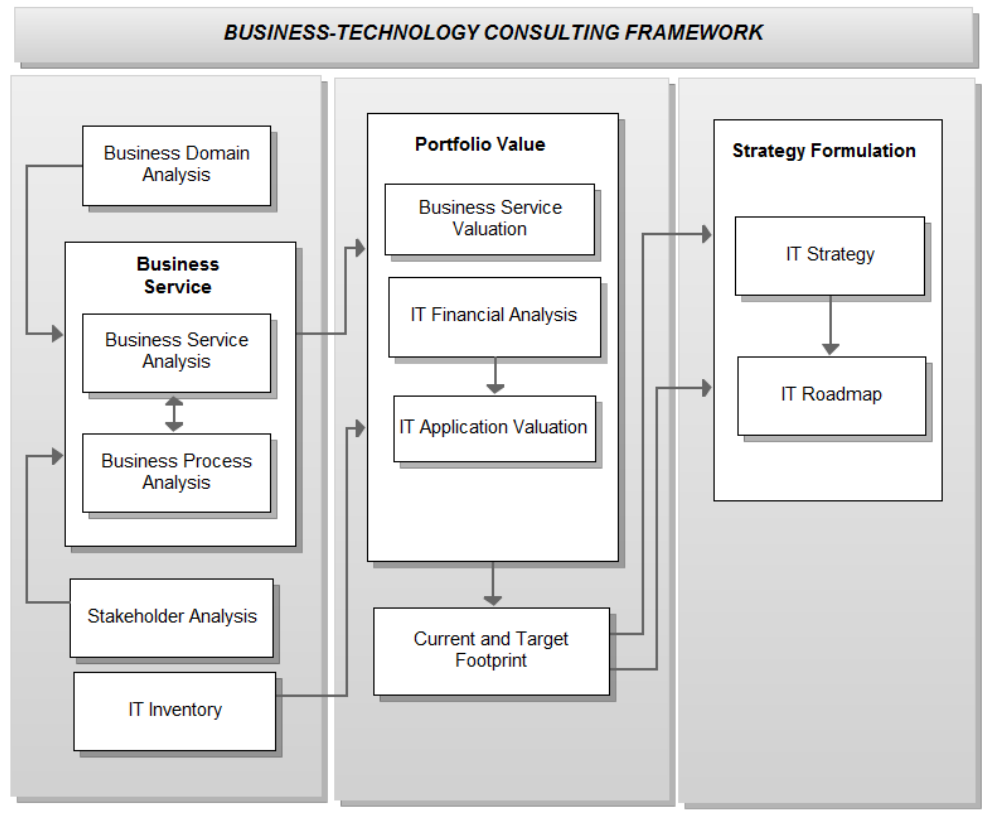
Figure 1. Business-Technology Alignment Consulting Framework (Liu, et al.,